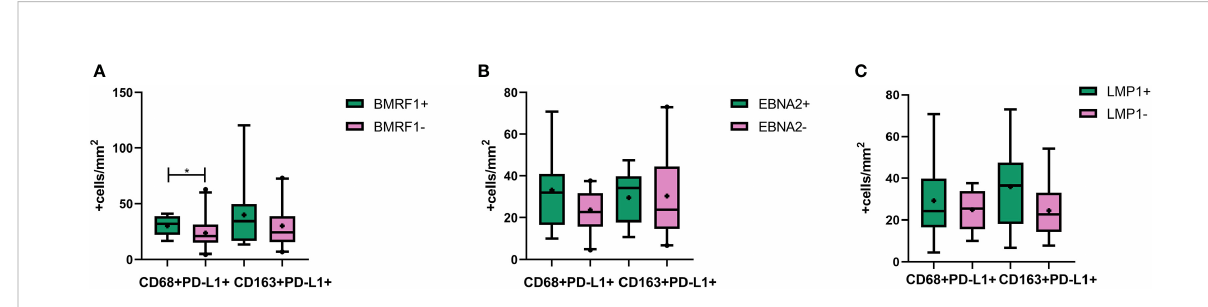
FIGURE 4 CD68 and CD163 macrophages ’ PD-L1 expression in (A) the presence and absence of BMRF1 lytic viral protein, (B) the presence and absence of EBNA2 latent viral protein, and (C) the presence and absence of LMP1 latent viral protein. *p <